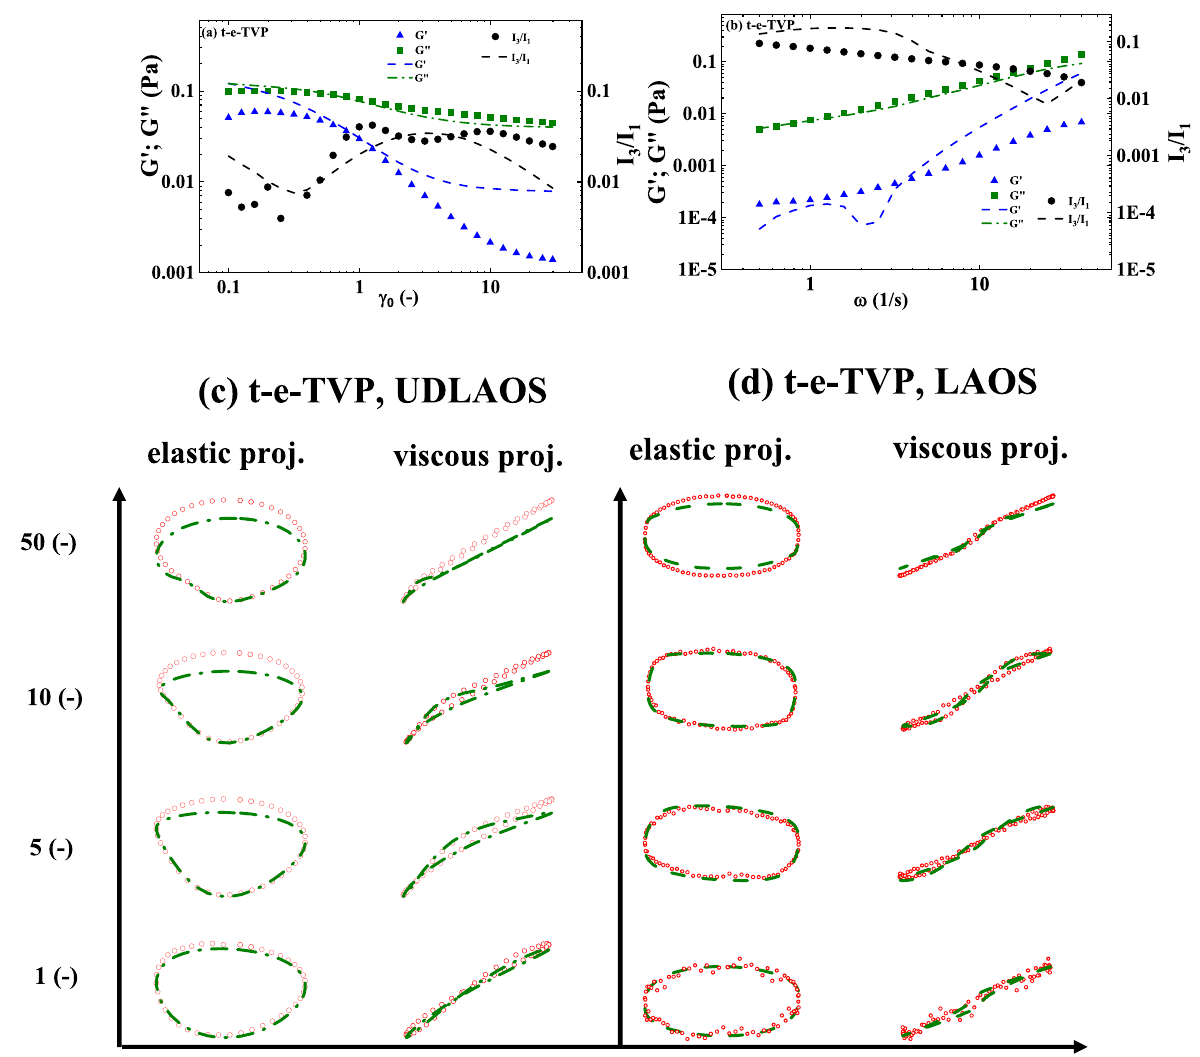
Figure 3. t-e-TVP prediction of ( a ) amplitude sweep executed at ω = 12.566 (rad/s); ( b ) frequency sweep executed at γ 0 = 10 ( − ) ( c ) elastic and viscous UDLAOS projections (green lines); and ( d ) elastic and viscous LAOS projections (green lines). (All UDLAOS and LAOS were conducted at ω = 1 (rad/s), and corresponding strain amplitude). Red dots indicate data; x-axis units are frequency (rad/s); y-axis units are strain amplitude (−). (Donor 1, Dataset 1) 49